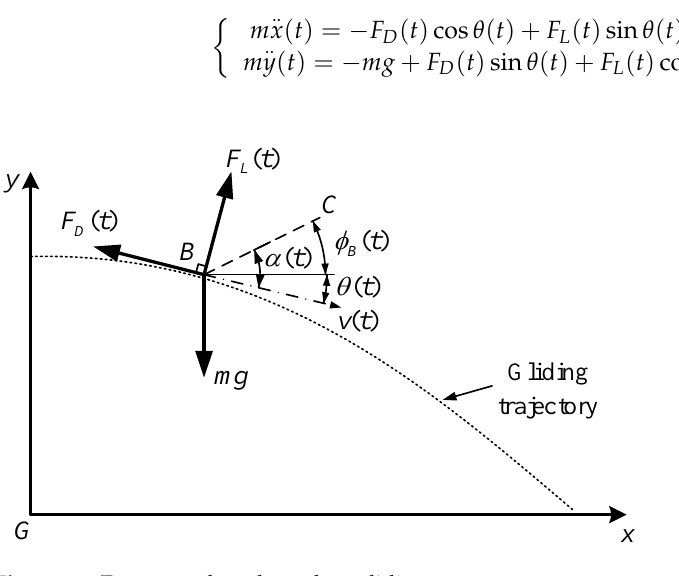
Figure 17. Forces on the robot when gliding.